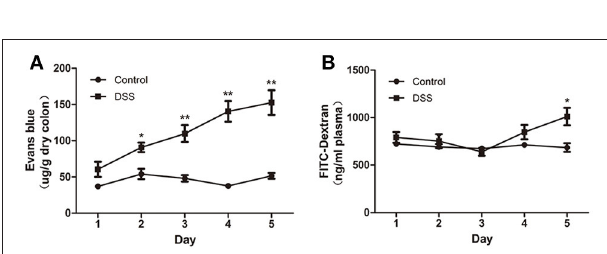
FIGURE 3 | DSS administration increased colonic VP that preceded increased colonic EP in rats. (A) Quantitative measurement of VP by extracting extravasated Evans blue in the colonic mucosa. (B) Quantitative measurement of colonic epithelial permeability by determining serum concentration of FITC–dextran. Both VP and EP in the same animal were measured. n = 8. * P < 0.05; ** P < 0.01 vs. control